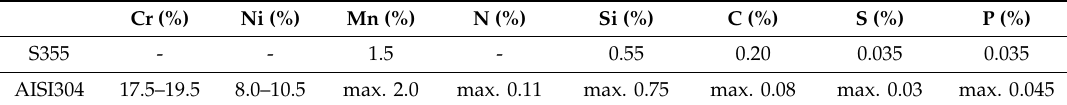
Table 1. Chemical composition of S355 (EN10025-2) and X5CrNi18-10 (EN10088-3) steel